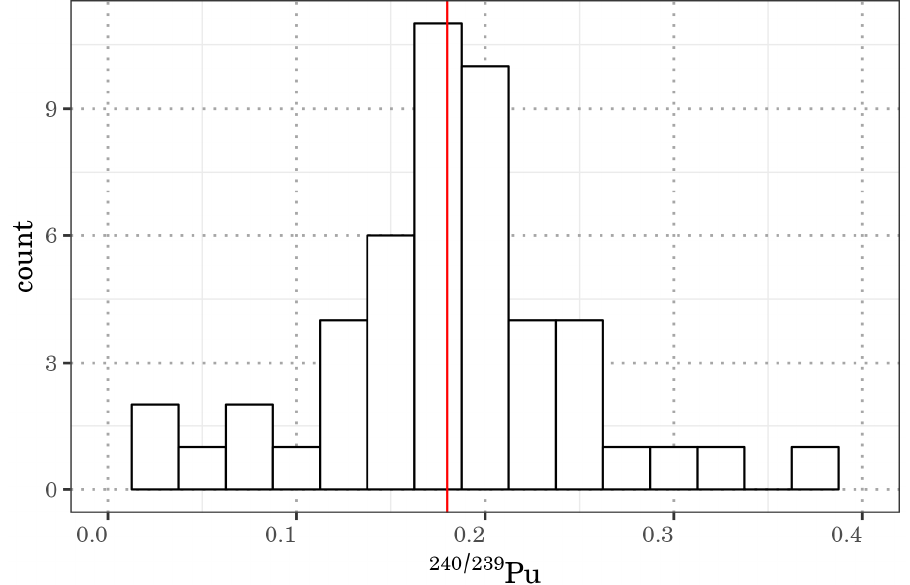
Figure 7. Distribution of the 240/239 Pu values in marine sediments. The red line shows the global fallout value.